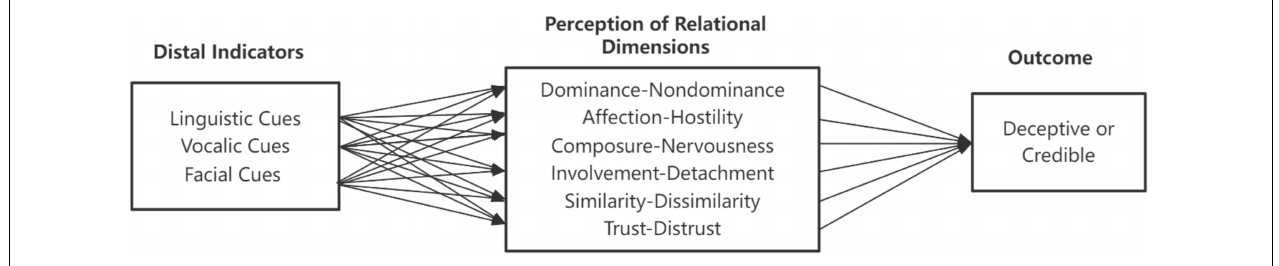
FIGURE 1 | Brunswikian lens model of relational